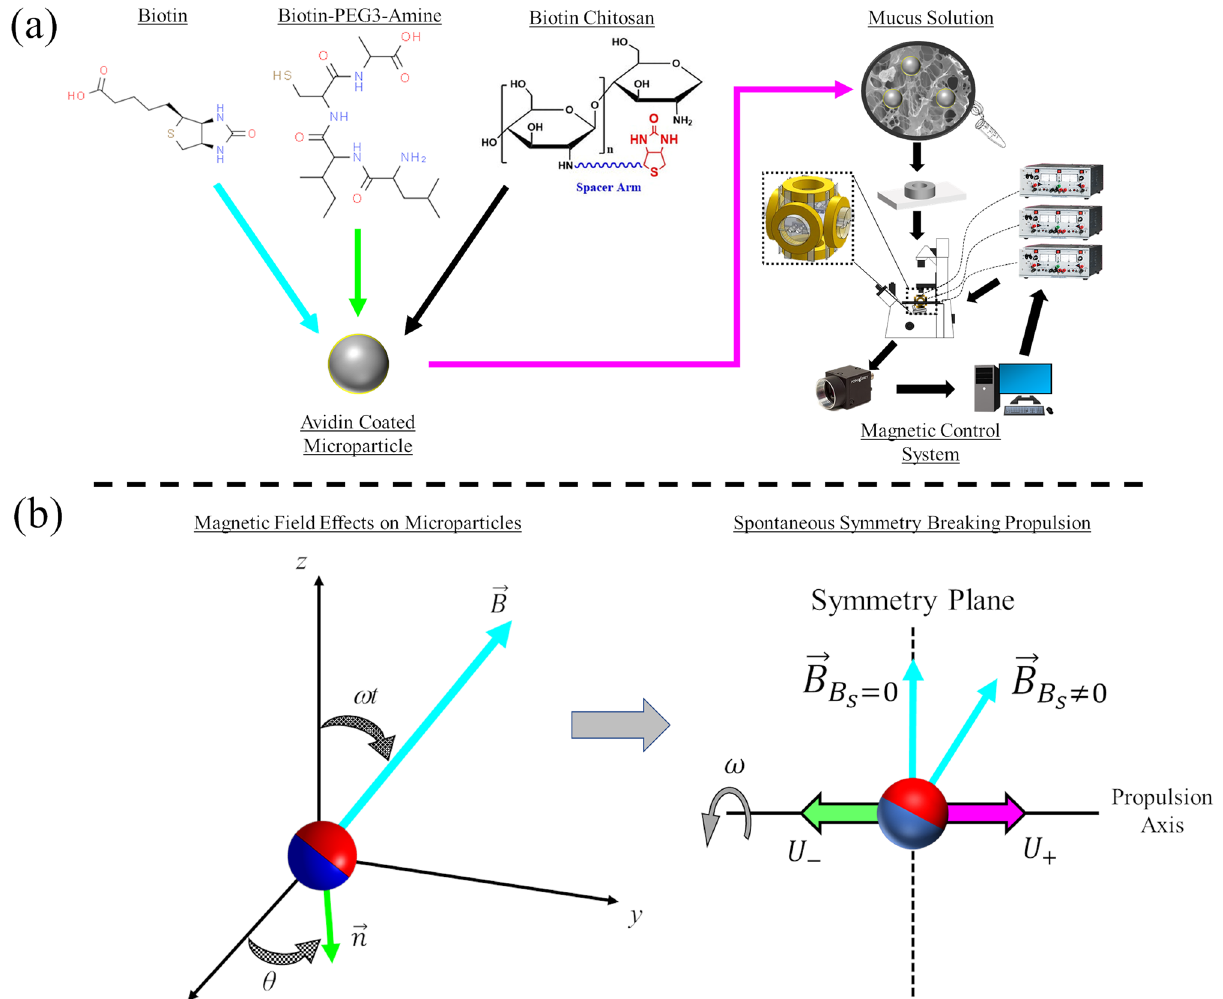
Figure 1. Overview of experimental setup and magnetic field interactions. ( a ) Avidin coated magnetic microparticles are functionalized with one of three compounds: biotin, Biotin-PEG3-amine, or biotin chitosan. Functionalized microparticles are suspended in a 4% mucin solution and loaded into a sample chamber which is placed in the middle of an approximate Helmholtz coil system. Programmable power supplies and camera visualization are used to navigate microparticles through the mucus with rotating magnetic fields. Chemical structures were extracted from Chemspyder and HAworks. ( b ) Magnetic fields produced from the Helmholtz coil system and their relationship to Eqs. (1–3). When torqued by a magnetic field, a microparticle in a rod- climbing-like fluid will propel along a propulsion axis perpendicular to its plane of symmetry. Two propulsion states can be achieved ( U + , U − ) randomly when no static field is applied ( B s = 0). Either propulsion state can be selected at will when a non-zero static field is applied ( B s ≠ 0). Red and blue hemispheres represent magnetic